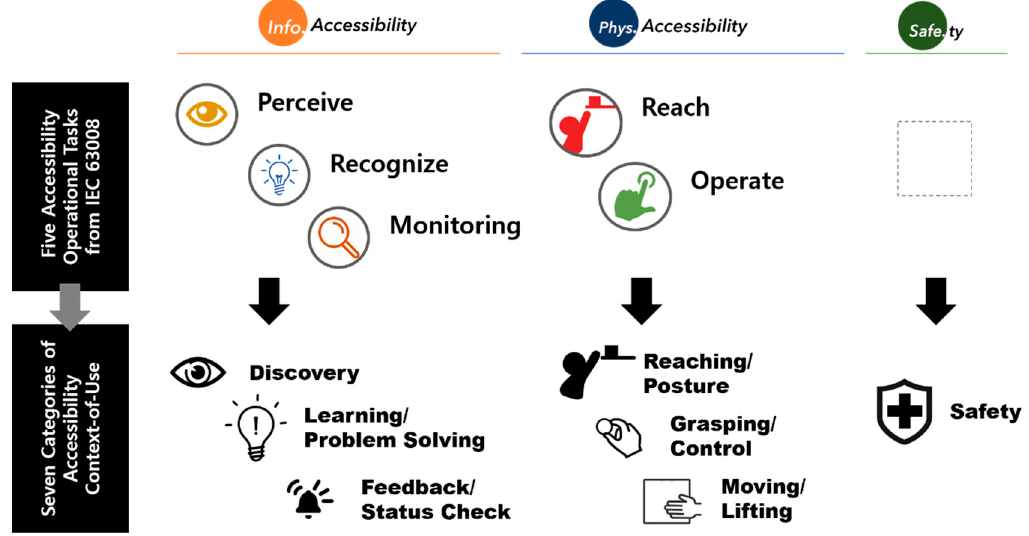
Figure 7. Seven categories of accessibility context-of-use expanded from the five tasks in IEC 63008.